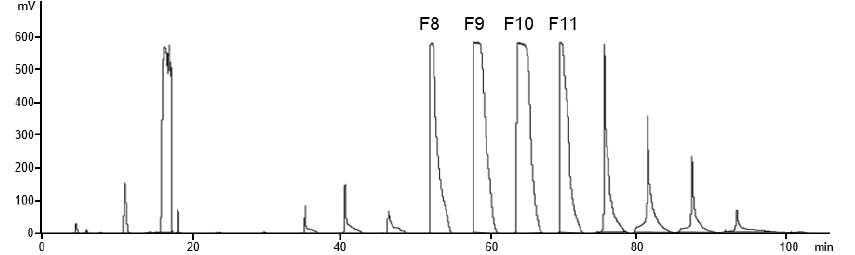
Figure 9. HPLC-Chromatogram of MC-MeOBz (DS Me 1.91) on a semipreparative column (Polaris 5 Si-A 250 × 10.6 mm), DCM/2-PrOH, 4.5 mL/min, 3 min hold for each adsorption and desorption step; UV-detection at 257 nm. Injection: 1 mL; c 6.8 mg/mL in DCM.